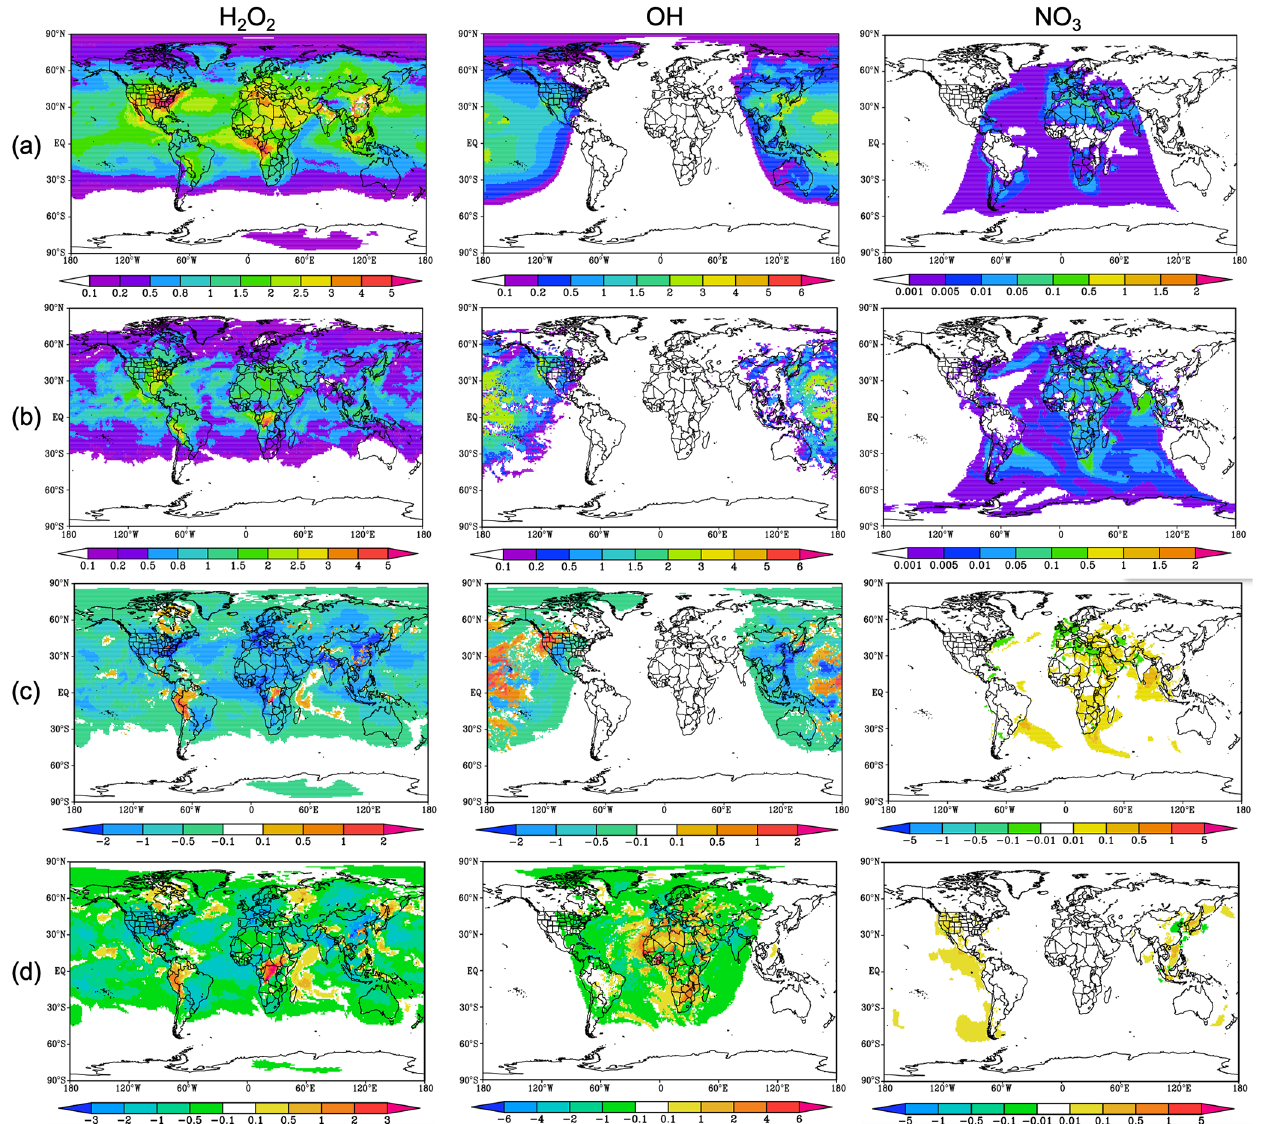
Figure 3. Comparisons of 5d forecast starting from 00:00UTC on 29 July 2016 of surface H 2 O 2 , OH, and NO 3 between (a) GOCART and (b) RACM_GOCART schemes, and their differences (RACM_GOCART minus GOCART) at (c) 00:00UTC and on (d) 3 August 2016. Unit: